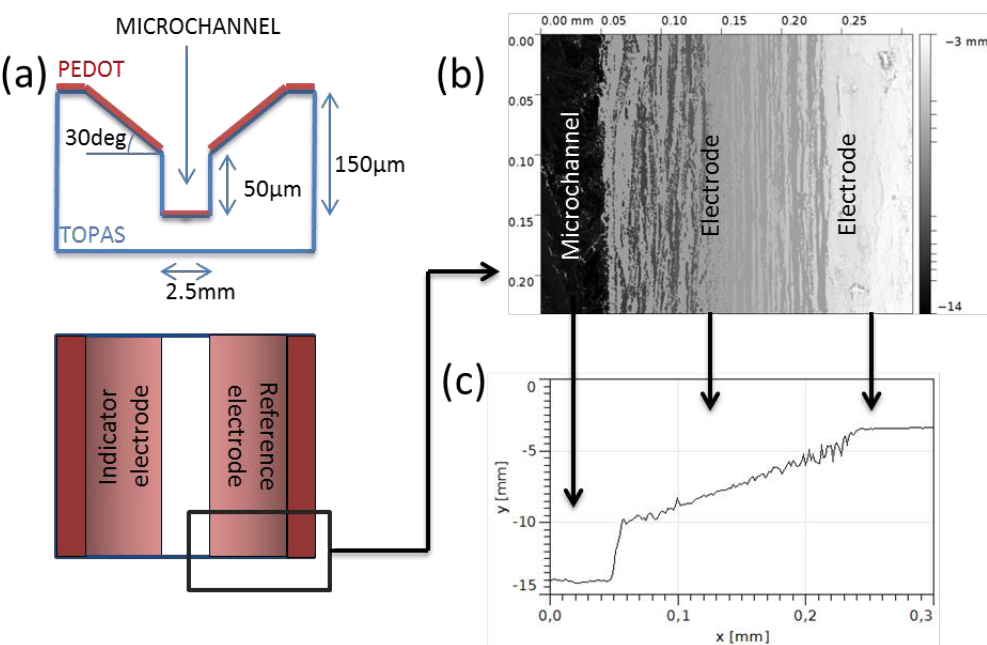
Figure 2. ( a ) Design of the device. A microfluidic channel is integrated with two PEDOT electrodes with oblique sidewalls (in red); ( b ) Top-view optical image of the device embossed on a PEDOT/TOPAS substrate; ( c ) Height profile of the embossed microchannel.